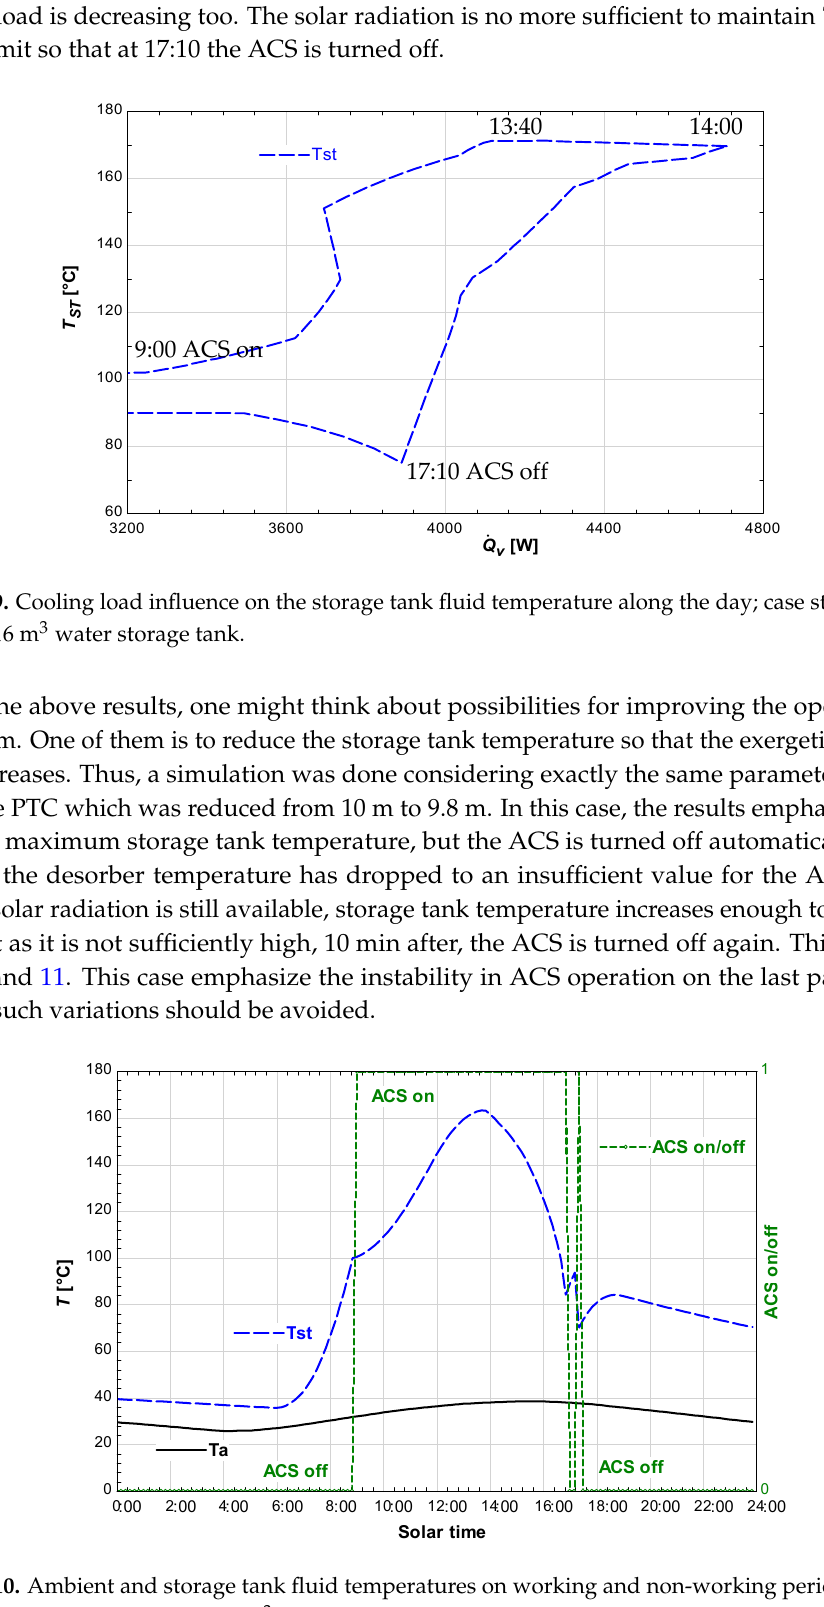
Figure 10. Ambient and storage tank fluid temperatures on working and non-working periods of the ACS; case study 9.8 m PTC, 0.16 m 3 water storage tank .